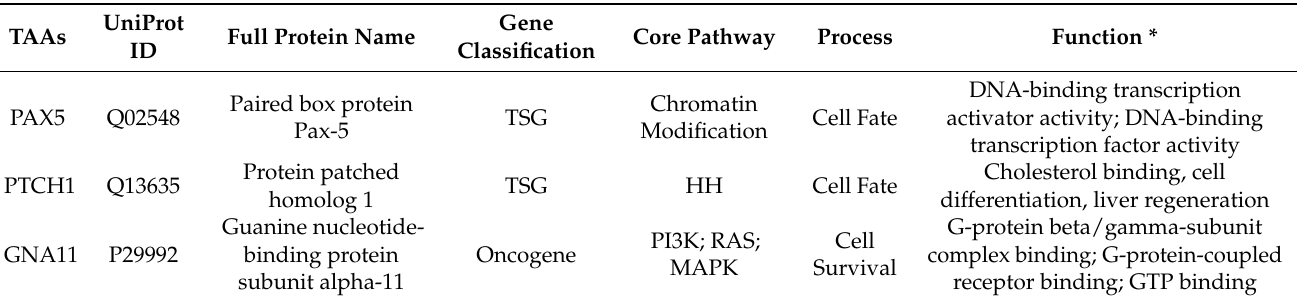
Table 1. Characteristics of PAX5, PTCH1, and GNA11.